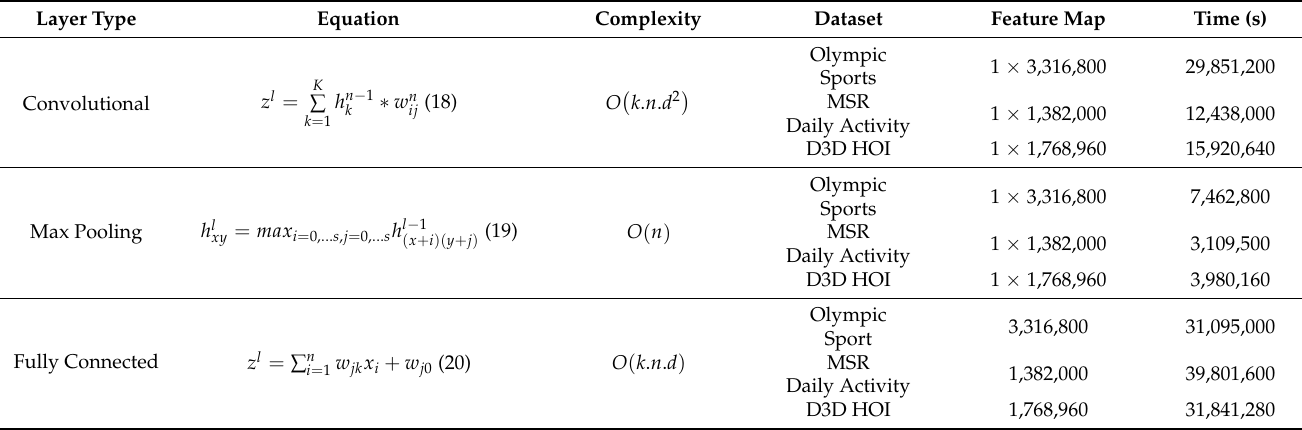
Table 2. Computational complexity of the GCN